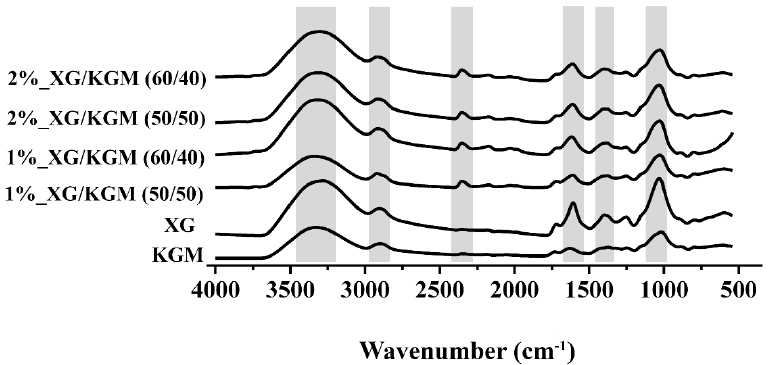
Figure 3. FTIR spectra of the individual components (XG and KGM) and of the different blends (1%_XG / KGM_(50 / 50), 1%_XG / KGM_(60 / 40), 2%_XG / KGM_(50 / 50) and 2%_XG / KGM_(60 / 40)) used for the production of